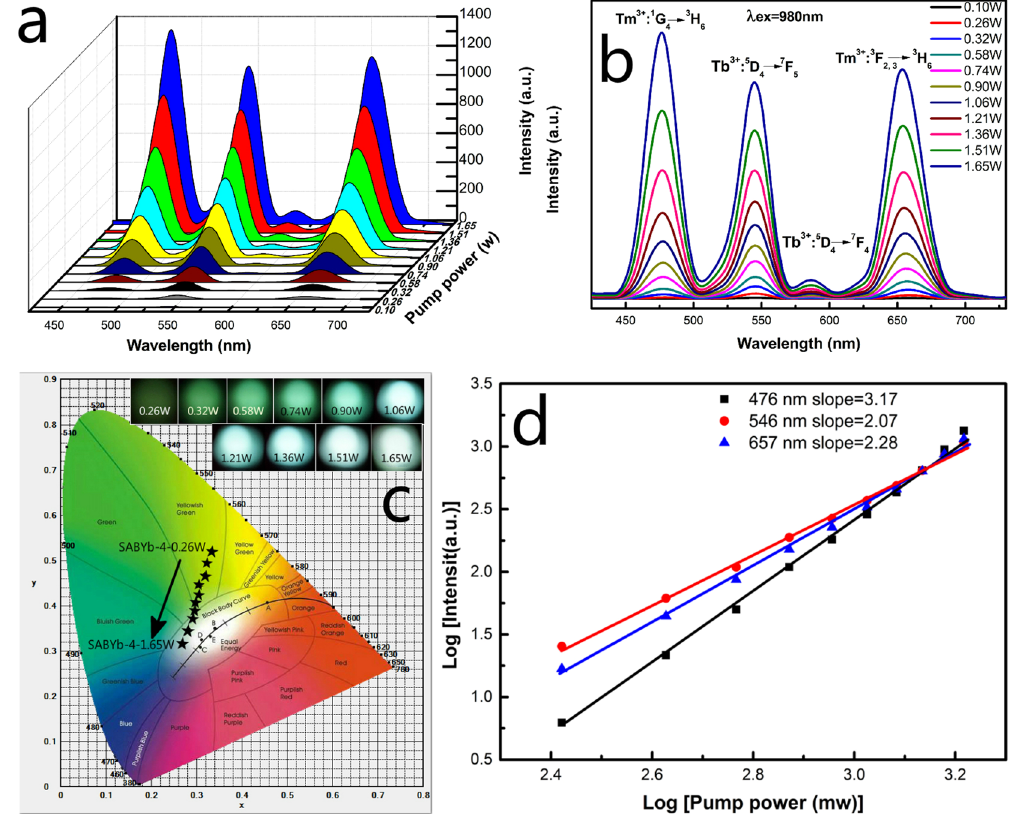
Figure 7. ( a and b ) The UEC emission spectra of the SABTm-1 glass-ceramics under adjustable power excitation of 980 nm. ( c ) CIE (X, Y) coordinate diagram showing chromaticity points of Tb 3 + and Tm 3 + luminescence in the glass-ceramics samples. ( d ) Log–log plots of the UEC emission intensity vs. the excitation power for the SABTm-1 glass-ceramics.